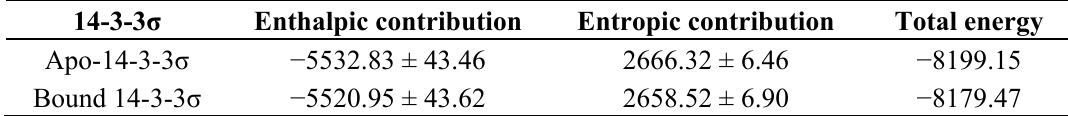
Table 1. Free energies for 14-3-3 σ protein